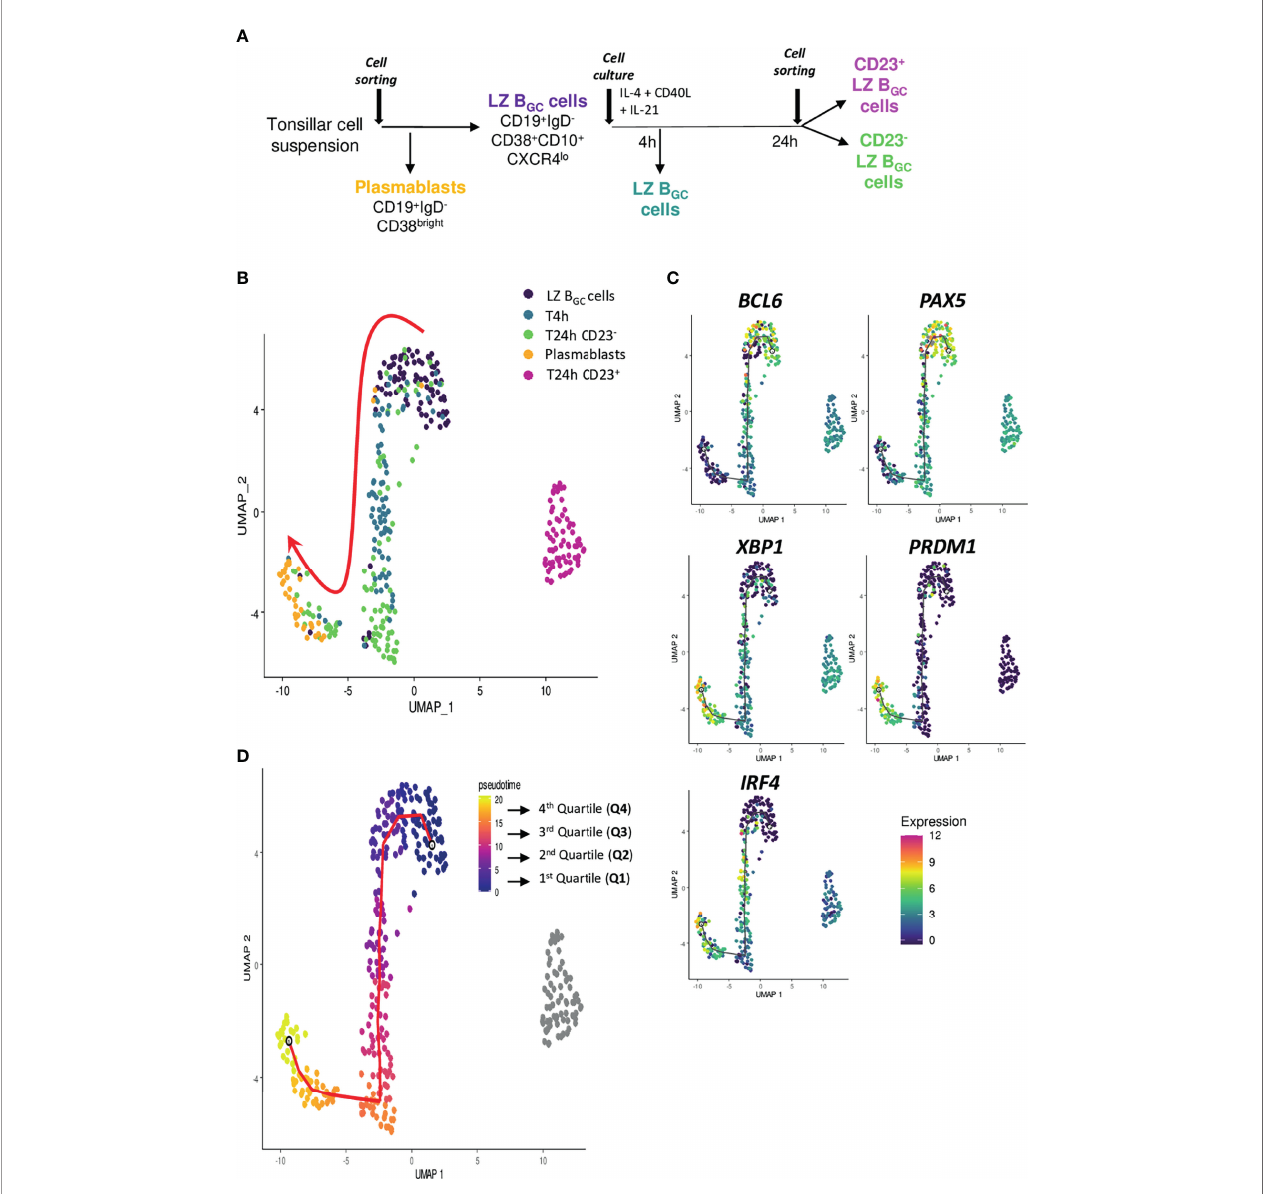
FIGURE 5 | Cell destiny of human LZ B GC -cells after Tfh-like stimulation. (A) The experimental plan, with fi ve different cell populations (colored script) analyzed using sc-RTqPCR. (B) The UMAP representation (colored according to the experimental conditions) highlighted two different fates as a function of CD23 expression. (C) Projection of B cell identity genes (BCL6 and PAX5 ) and PC identity genes ( PRDM1 , XBP1 , and IRF4 ) onto the UMAP representation. (D) The UMAP representation (colored according to the Monocle pseudotime), showing an ordered, progression in four quadrants from LZ B GC -cells to